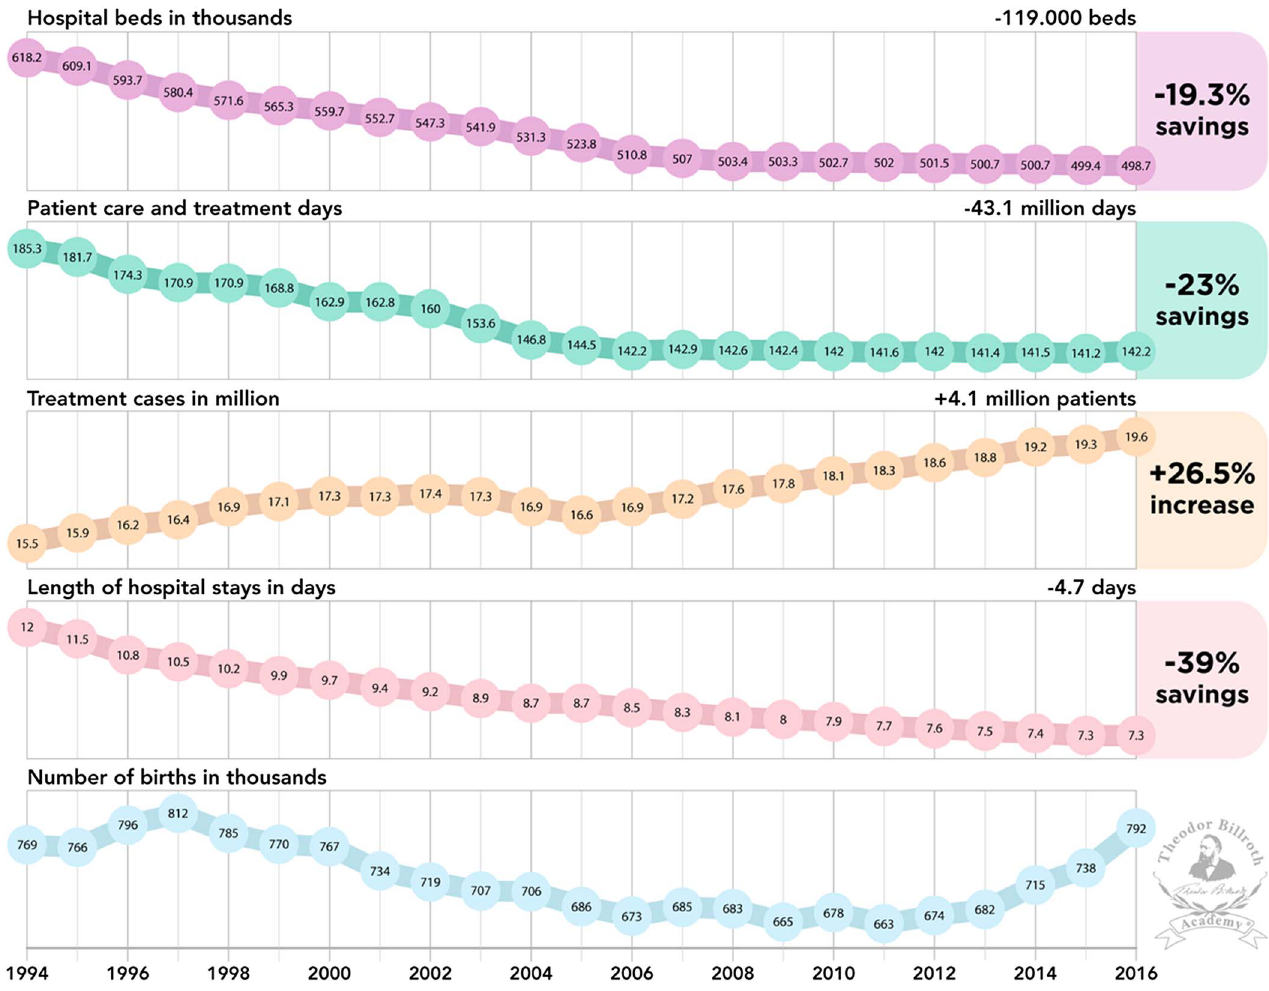
Figure 4. Development Hospital beds in thousands, patient care treatment days, treatment cases in millions, length of hospital stays in days, number of births in thousands in Germany during a 22-year time period between 1994 and 2016. These data are modi fi ed and completely actualized according to a prior partial analysis from 2011